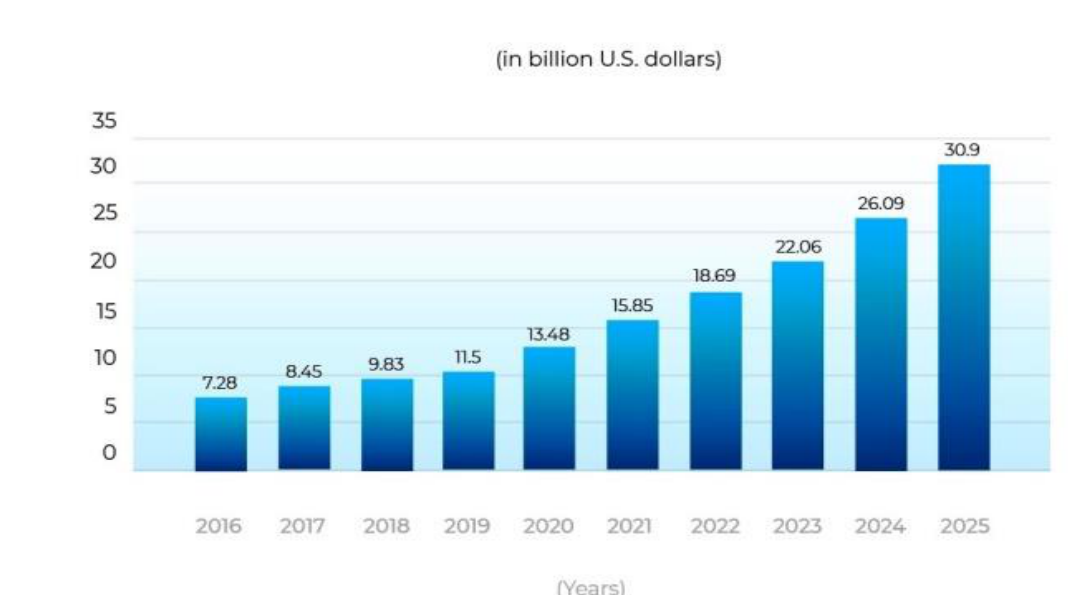
Figure 1. Size of the Internet of Things (IoT) security market worldwide form 2016 to 2025 (Source: